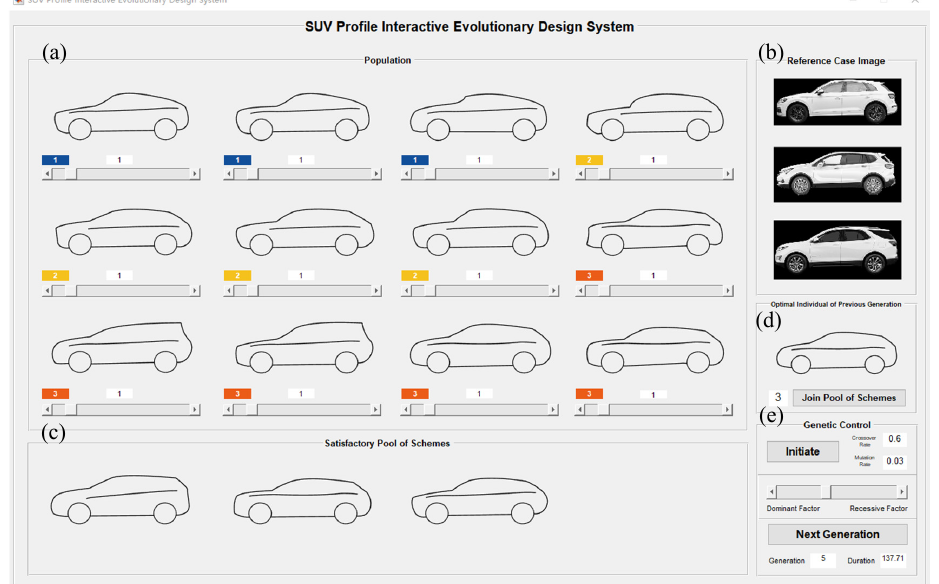
Figure 6. Interface for iterative evolution of schemes: ( a ) Part A, ( b ) Part B, ( c ) Part C, ( d ) Part D and ( e ) Part E.